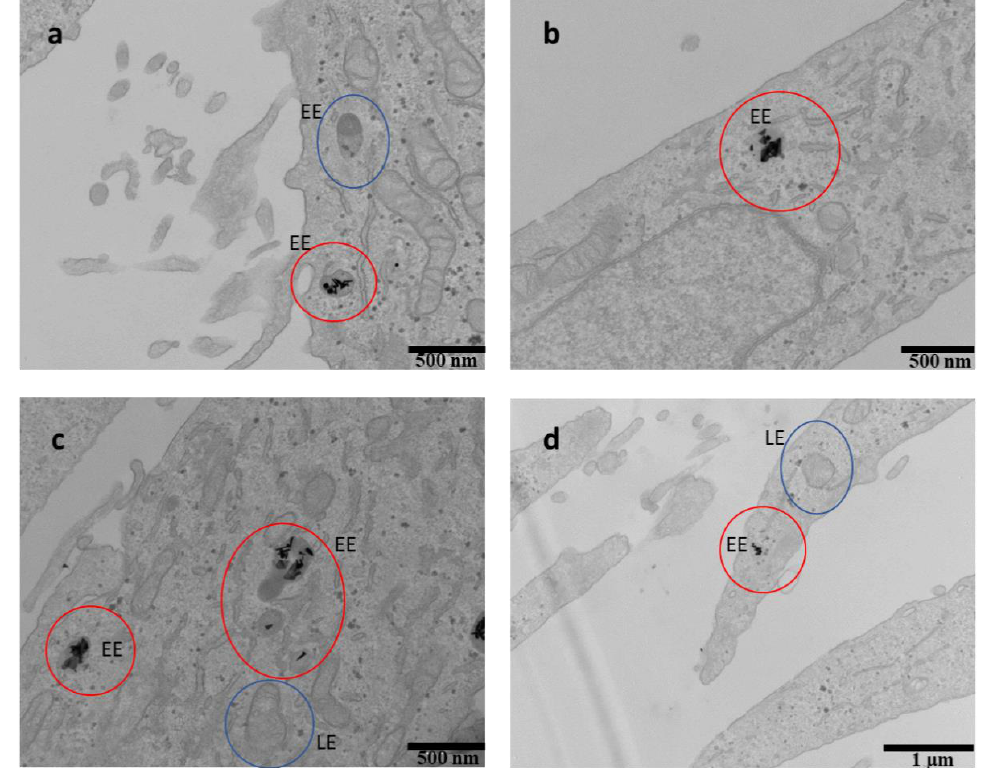
Figure 8. TEM images of HeLa cells after treatment with AuNR-BSA-r 8 incubated for 24 h ( a – d ). Red circles show the in- ternalized AuNPs. EE: early endosomes and LE: late endosomes. Blue circles showing examples of vacant LE or EE.